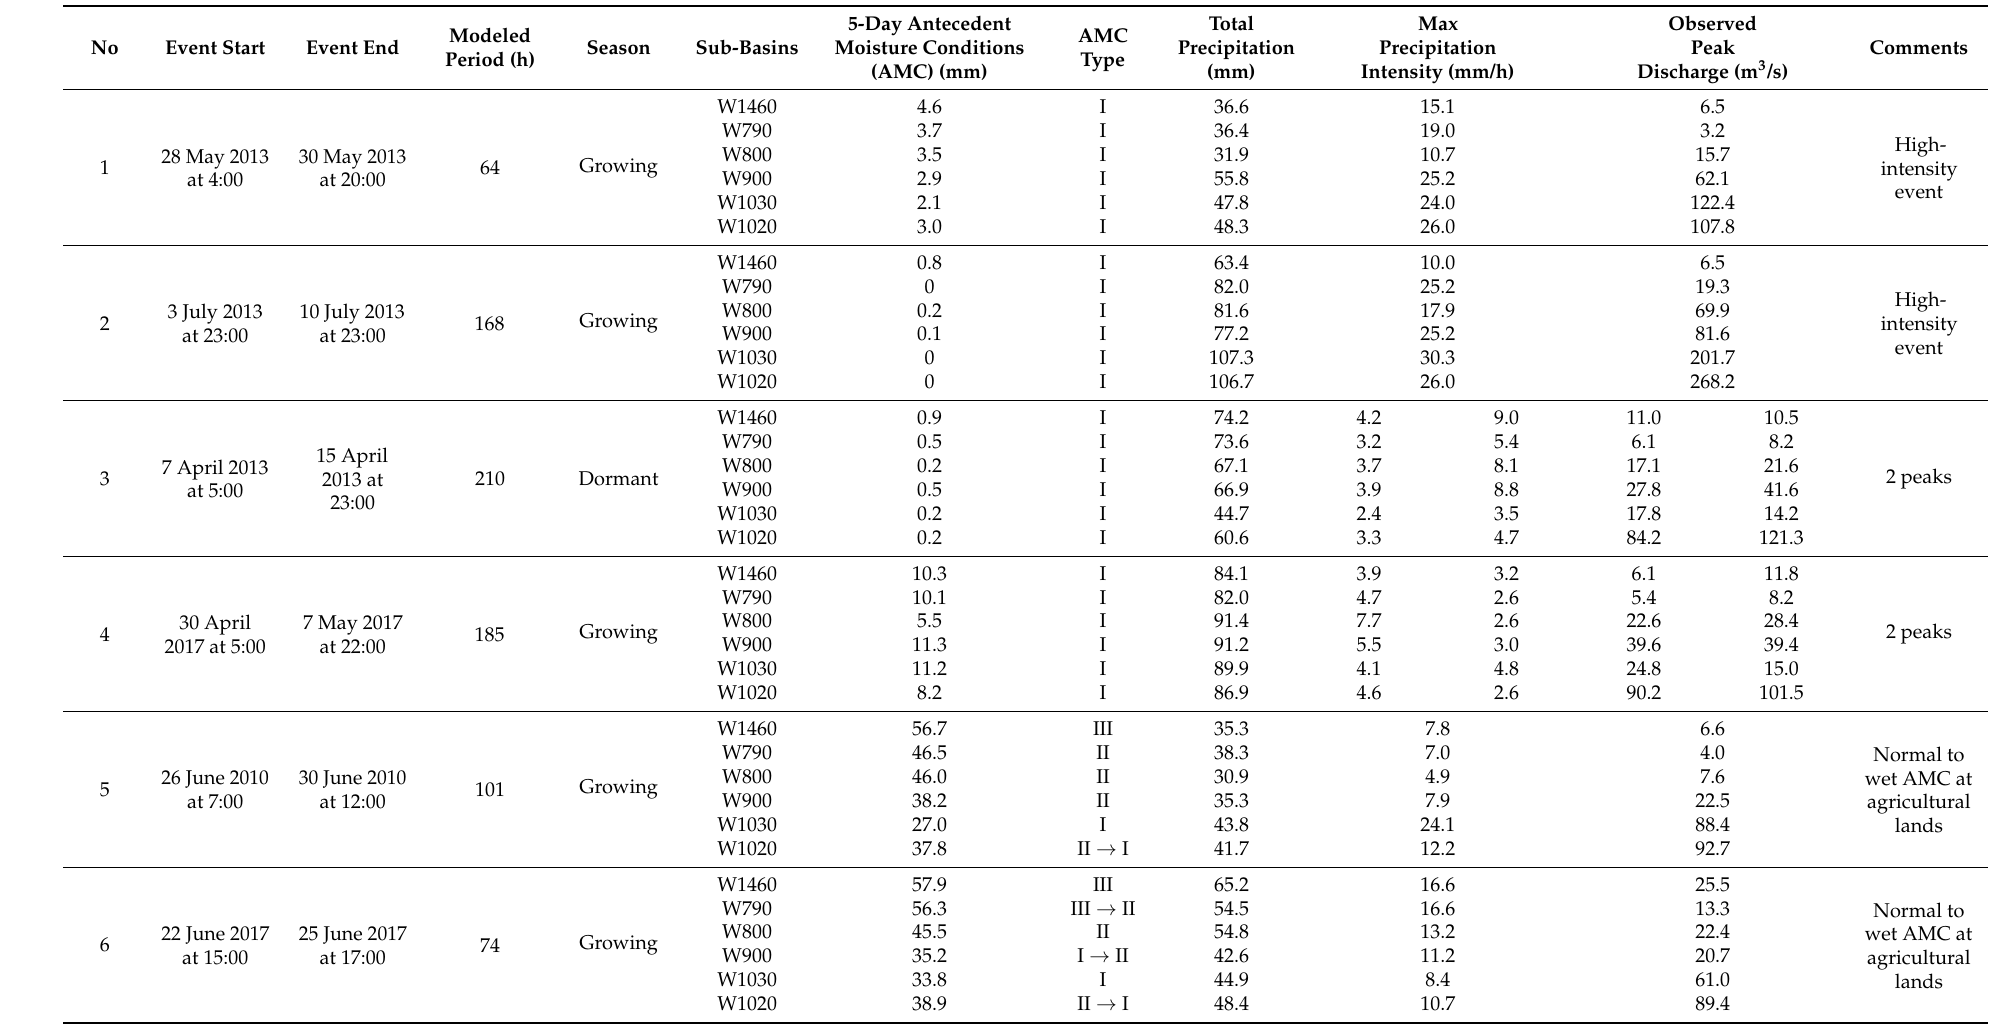
Table 2. Characteristics of the studied precipitation